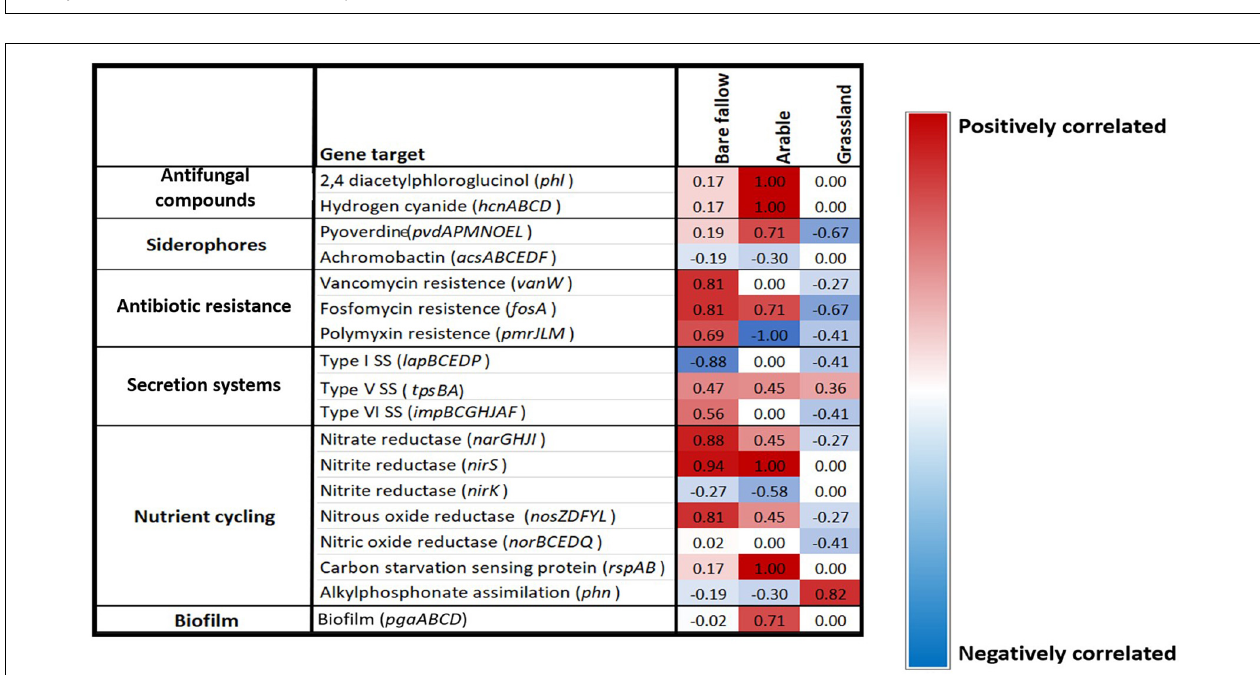
FIGURE 6 | 1-Aminocyclopropane-1-carboxylate consumption by isolates with the acdS gene grown in media with ACC as the sole nitrogen source. The mean ACC consumption for isolates from arable, bare fallow, and grassland treatments, grown in Dworkin and Foster (DF) + ACC medium with ACC concentration quantified by a ninhydrin colorimeter test at 24 and 48 h post inoculation.